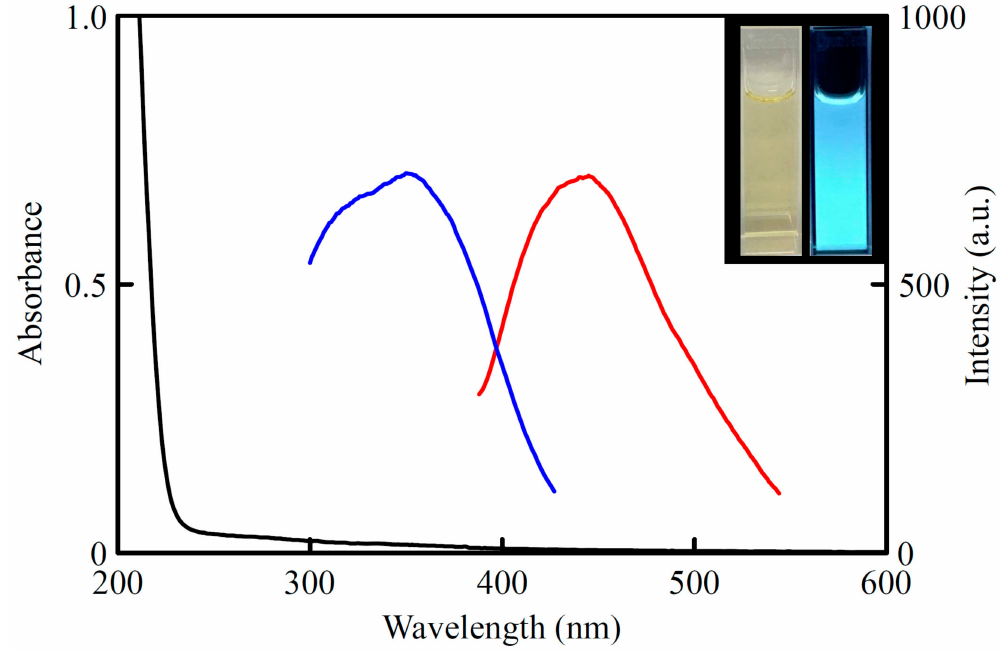
Figure 1. UV–Vis absorption spectrum (black) and fluorescence spectra (excitation spectrum: blue; emission spectrum: red) of the carbon dots (CDs). Inset: Samples excited by visible light and a 365-nm UV